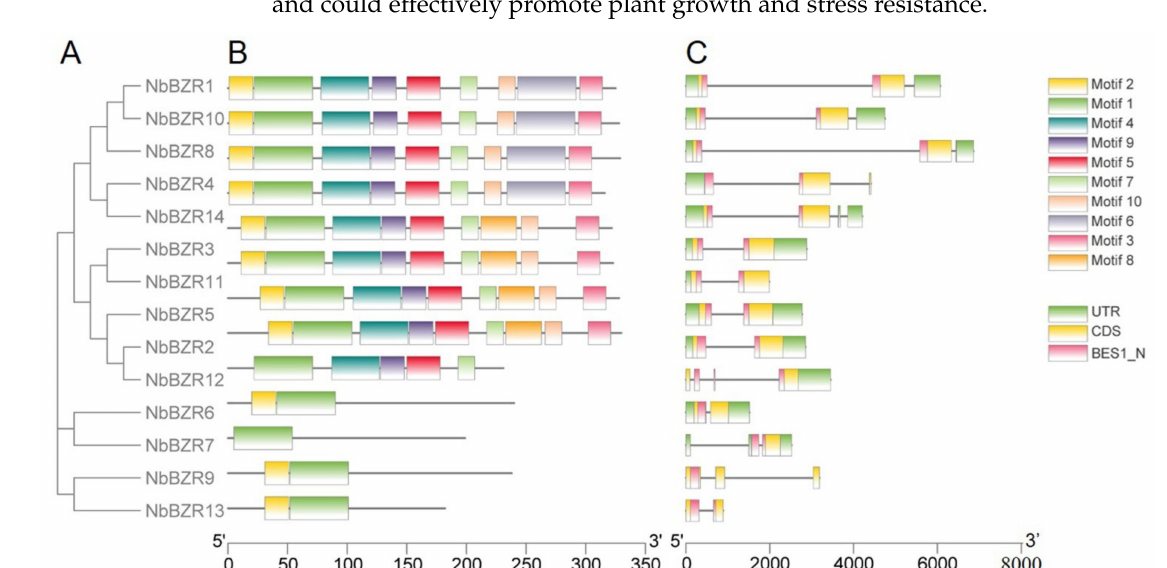
Figure 2. Analysis of conserved motifs, gene structure and domains in the BZR genes of N. benthamiana. ( A ) Phylogenetic tree constructed using the NbBZR protein sequences. ( B ) Ten types of conserved motifs are predicted in the NbBZR protein sequences. The different motifs are shown in different color boxes. The sequence information for each motif is provided in Supplementary Table S2. ( C ) The gene structure of NbBZR members (untranslated regions, exons, and introns are shown as light green boxes, yellow boxes and horizontal lines, respectively. The red boxes represent the BES1_N domain).